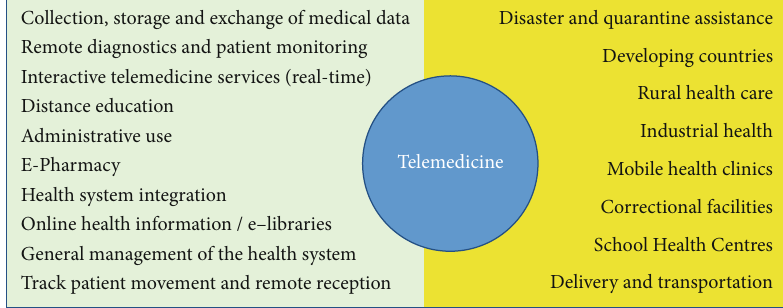
Figure 3: The applications of telemedicine in